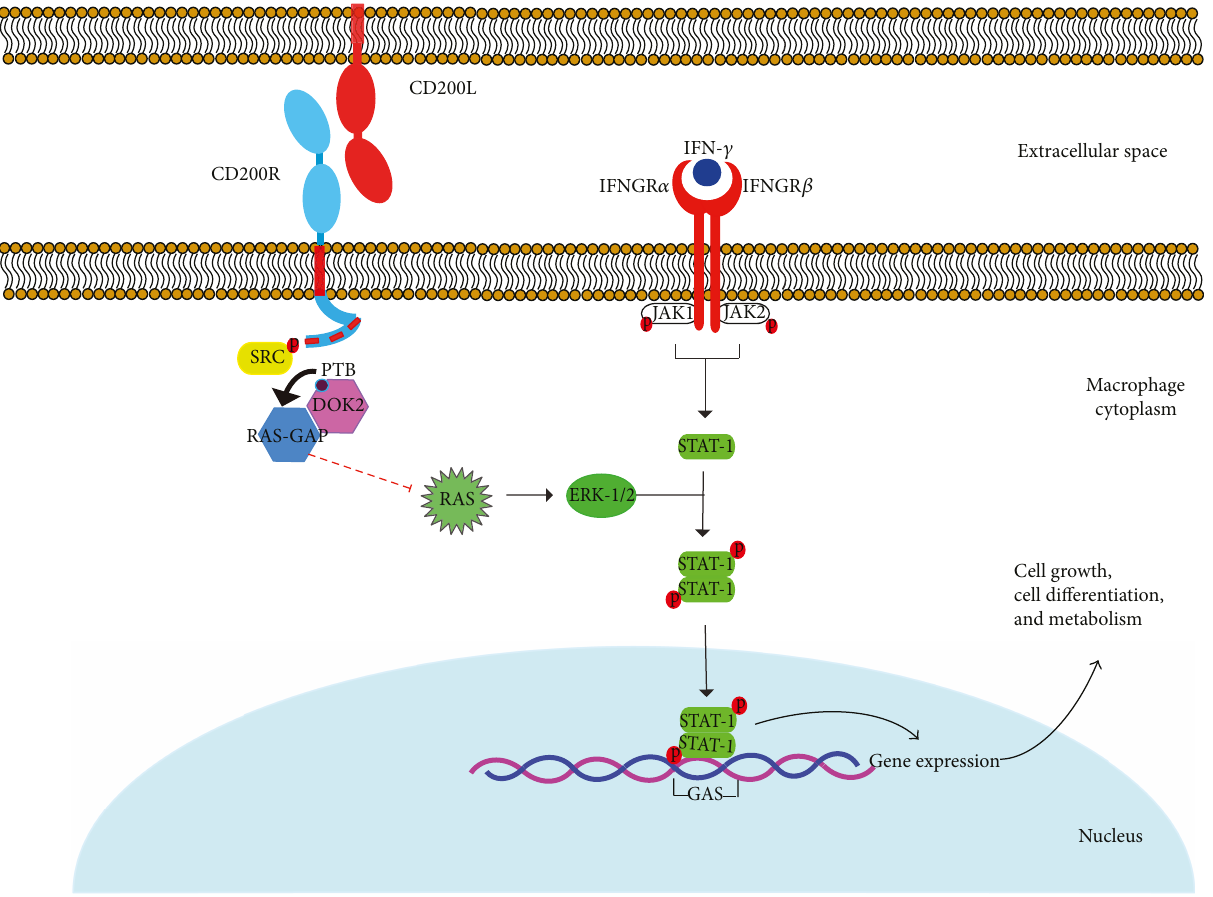
Figure 4: CD200R-induced signaling pathway. Interaction of CD200R with its ligand induces phosphorylation of the tyrosine residues (red squares) present in the intracellular portion of the receptor mediated by kinases of the Src family. This mechanism propitiates recruitment of Dok2 through its binding domain to tyrosine (PTB). Dok2 binds to the phosphorylated tyrosines, and it recruits the activator protein of Ras- GTPase (RasGAP), which inhibits Ras and downstream ERK activation. ERK is a MAP kinase which is involved in macrophages activation by IFN- γ . JAK/STAT-1 signaling pathway is required for cell activation, and STAT-1 is phosphorylated by JAK proteins and ERK-1/2 in turn to allow the gene expression for cell di ff erentiation, growth and metabolism, so then, if CD200R binds to its ligand CD200 it allows the inhibition of cell activation [74,